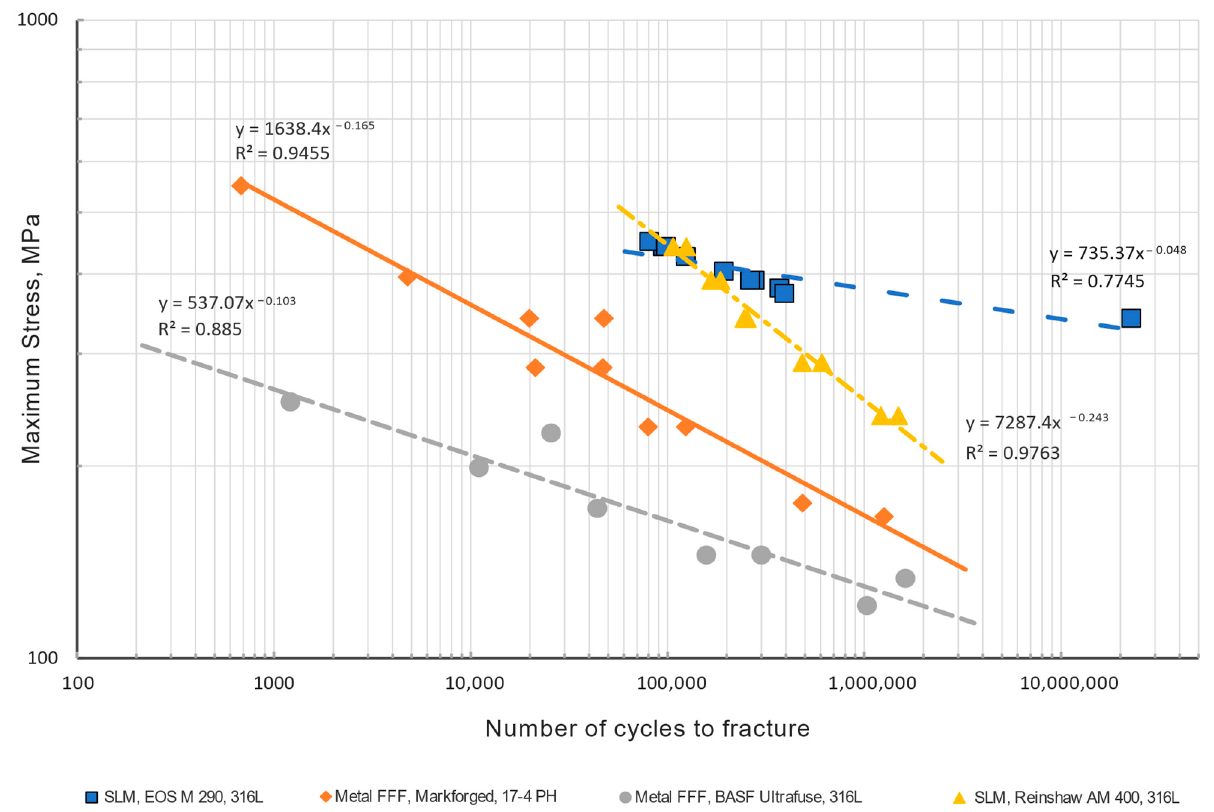
Figure 11. S-N curves for tested specimens; cycling tensile test with R = 0.1. (Two specimens of Ultrafuse 316L were broken in the grips, and their results were excluded.).